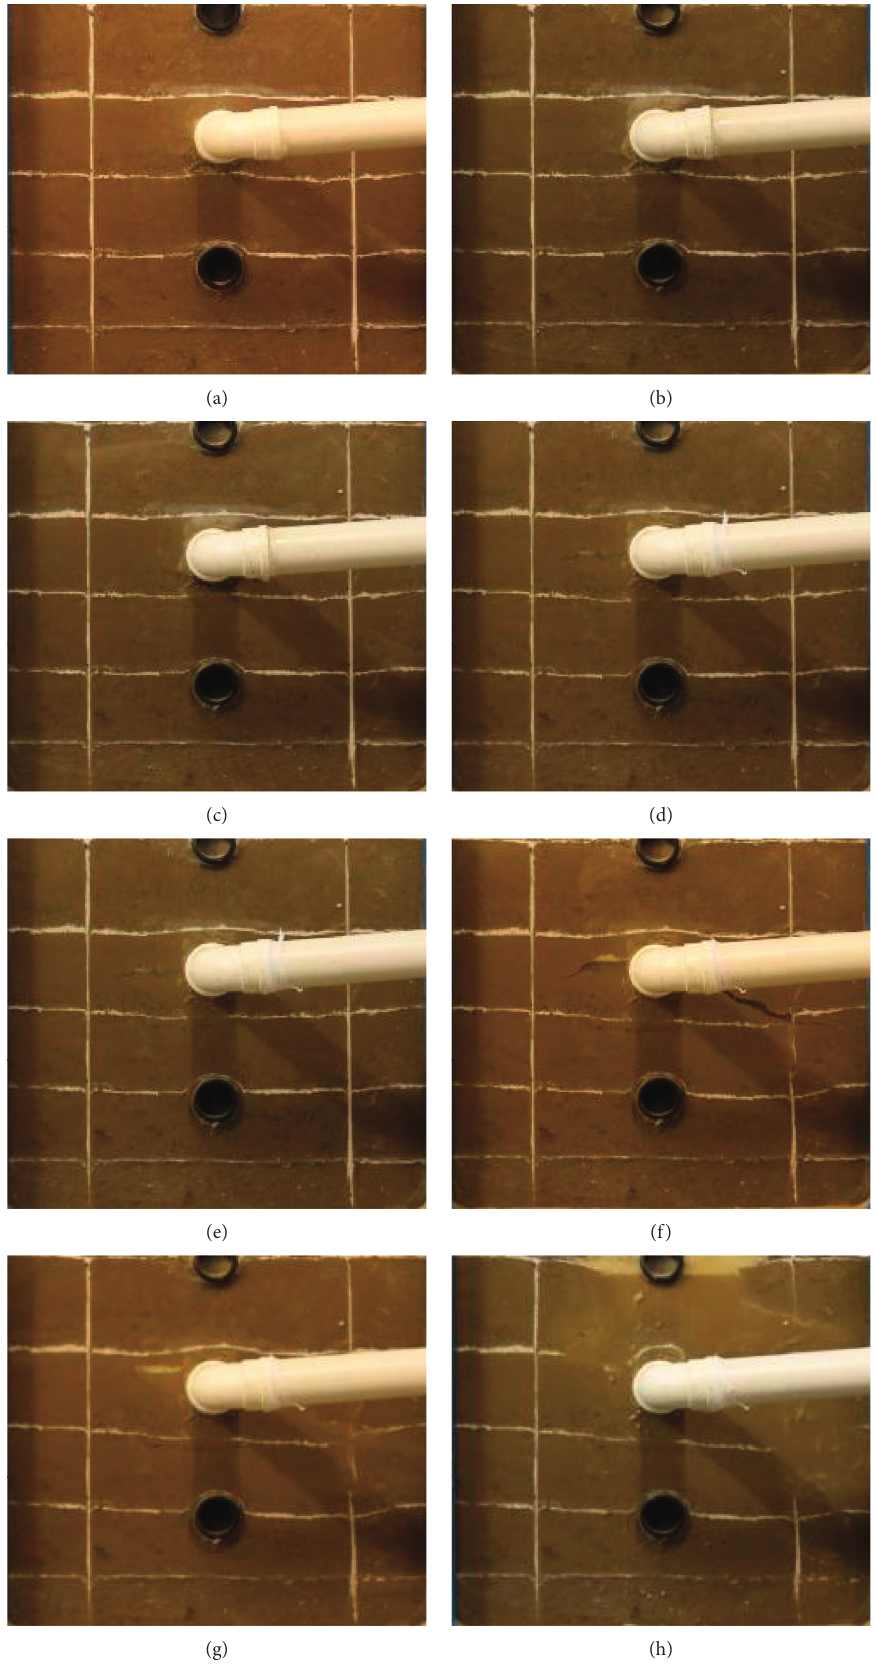
Figure 5: Experiment phenomenon of Condition 2. (a) 0min. (b) 40min. (c) 65min. (d) 100min. (e) 125min. (f) 160min. (g) 184min. (h)